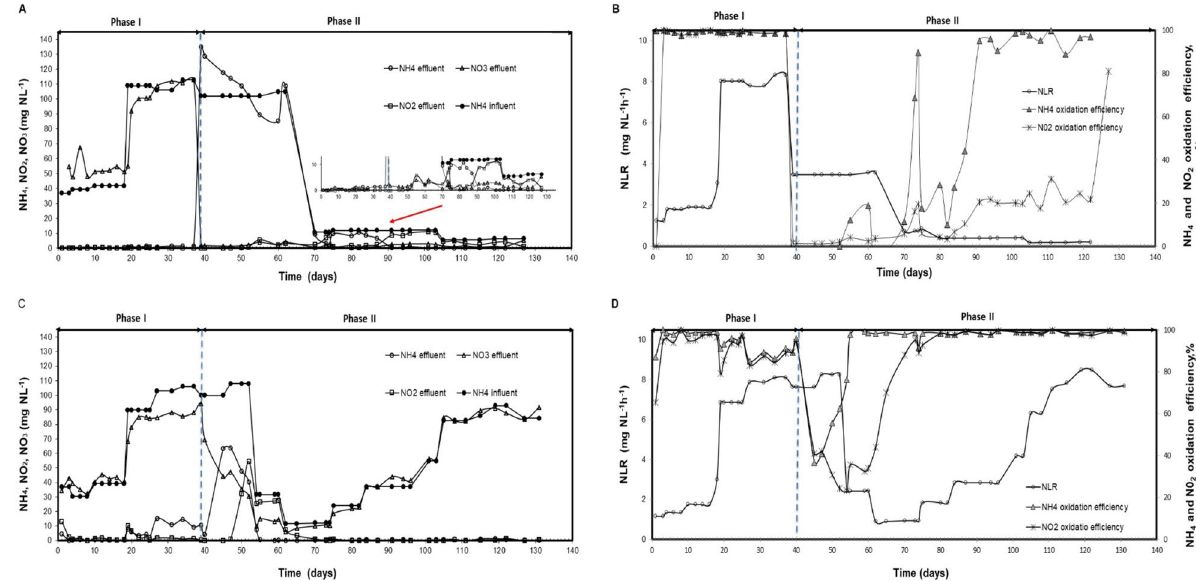
Figure 1. On the left side ( A , C ): ammonium concentration in the influent and ammonium, nitrate and nitrite concentrations in the effluent. On the right side ( B , D ): nitrogen loading rate (NLR), NH 4 + oxidation rate and NO 2 − oxidation rate during the whole experimental period. Freshwater reactor (FR) represented by A and